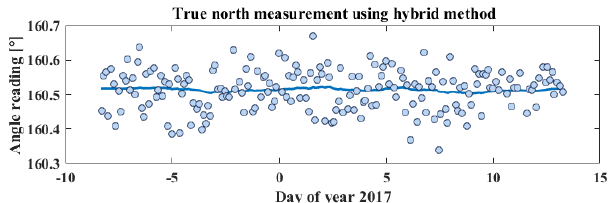
Figure 8. Series of true north measurements (trace on horizontal circle) obtained by means of hybrid method (Dots). The solid line corresponds to the true north determination after passing through a Kalman